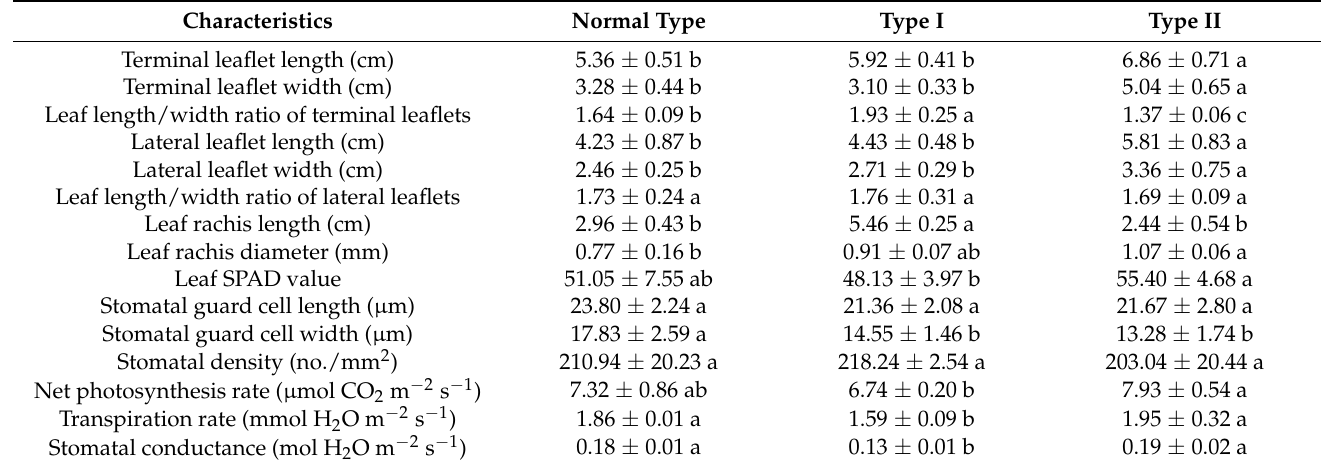
Table 4. Morphological, stomatal, and gas exchange analysis of the three types of plants regenerated in vitro from the immature seeds of wild A. trifoliate .